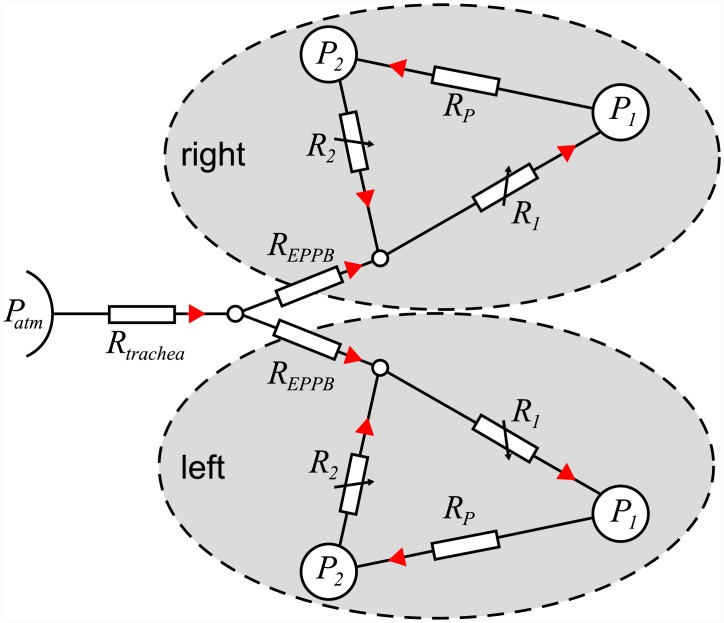
Schematic of the full avian model including left and right sides of the respiratory system.The caudal and cranial airsacs have pressures P1 and P2, respectively. The direction of positive flow rate is indicated by the red arrows. If we assume symmetry, we can reduce the model to consider only one side, which gives the model in Fig 1, with RT = 2Rtrachea + REPPB. The flows found in the reduced model will be for a single side of the animal, and will need to be doubled to find the total flow in the whole animal.